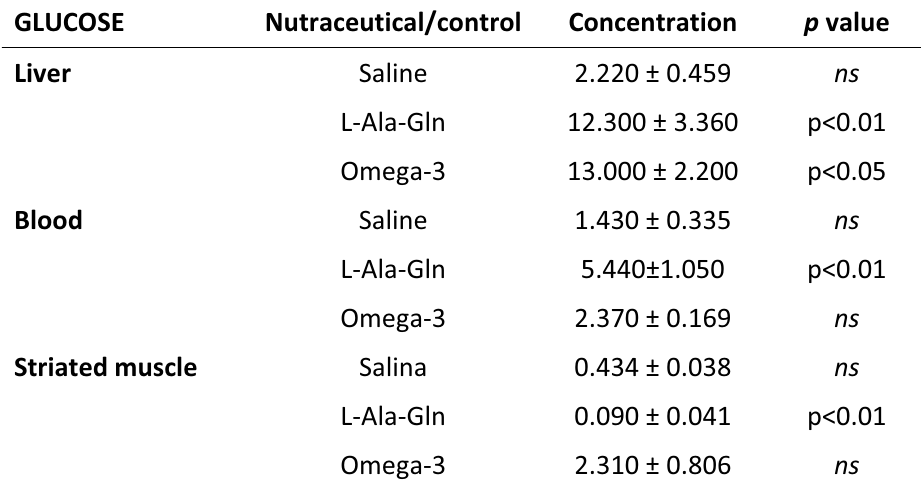
TABLE 3 - Mean glucose concentrations in the blood (µmol/ml) and tissue (mol/g) in groups G1 - treated with saline, G2 - treated with L-Ala-Gln and G3 - treated with Omega-3, 48 hours after sepsis induction